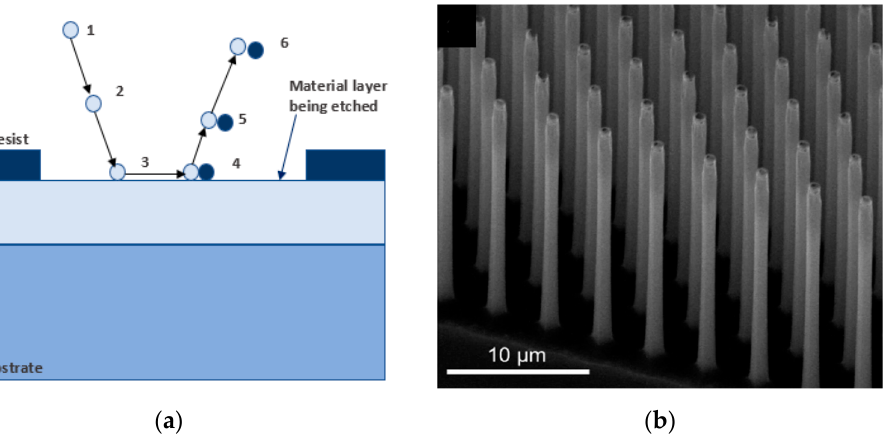
Figure 9. ( a ) Showing the steps of RIE (1: process gases are broken into chemically reactive plasma species, 2: diffusion of reactive species to substrate, 3: absorption of reactive species, 4: reaction between reactive species, 5: desorption of reaction by-products and 6: diffusion of by-products) (after Huff 2022) [113], ( b ) High-aspect ratio Si nano-wires using different mask material during ICP-RIE